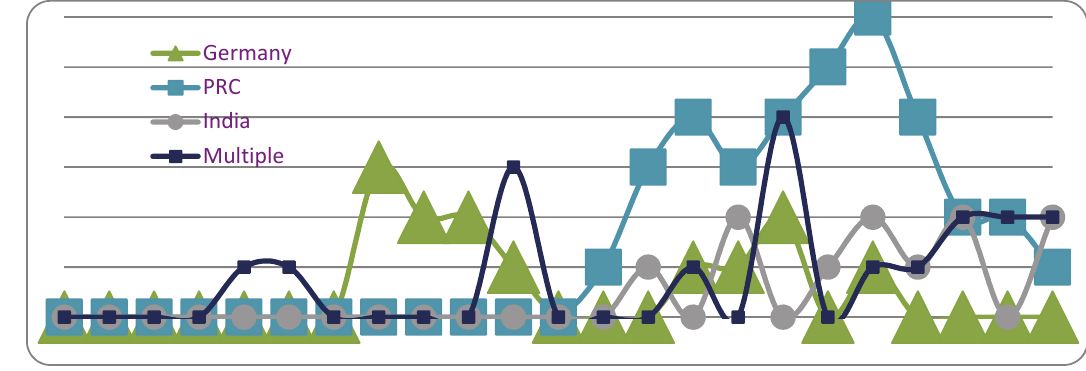
Fig. 2. Number of Life Insurance Efficiency Studies Regarding Germany, the PRC, India and Multiple Nations ( Year-by-Year)